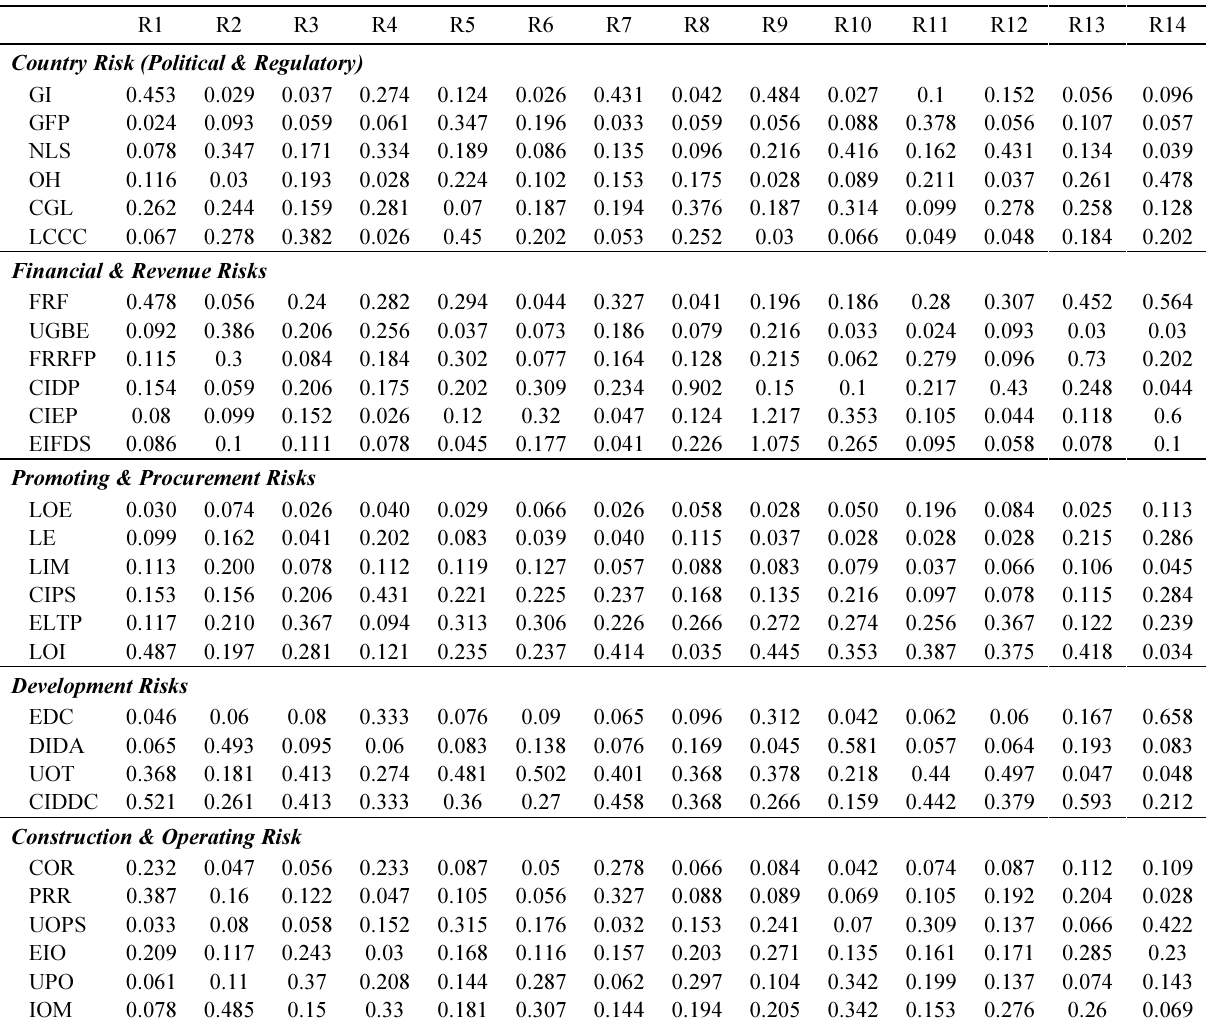
Table 3. Risk decision factors: local attributes